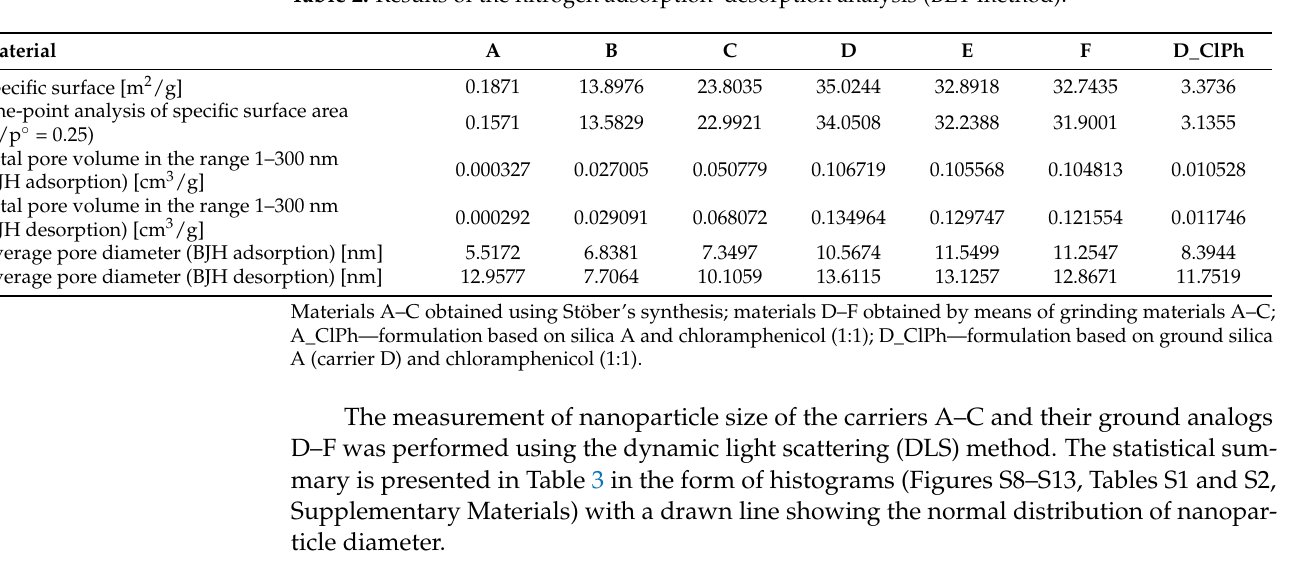
Table 2. Results of the nitrogen adsorption–desorption analysis (BET